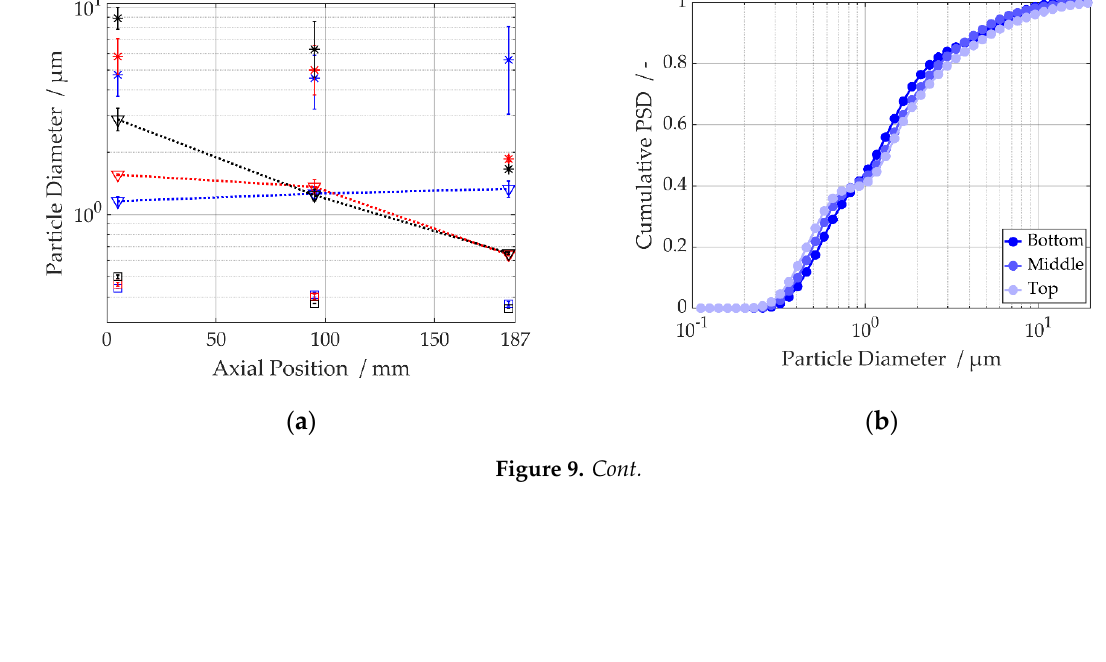
𝑥 90 . ( b – d ) Detailed particle size distributions for the